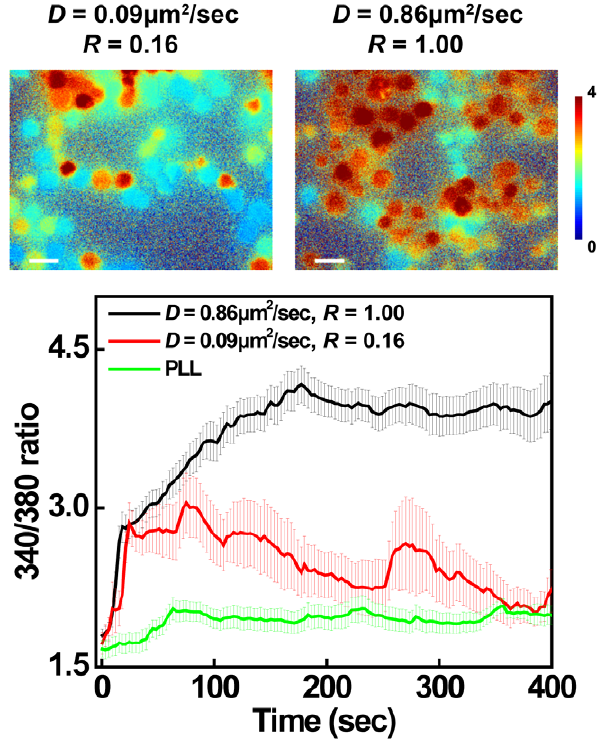
Figure 7. High ligand mobility triggers persistent intracellular calcium flux. Jurkat cells loaded with Fura-2 were plated on various bilayer surfaces, and intracellular calcium levels were monitored by widefield ratiometric imaging at 340/380 nm. Top, representative images of Fura-2 340/380 ratio after 20 minutes on different bilayer surfaces were depicted as a heat map (top). Scale bars=20 m m. Bottom, average Fura-2 ratios in cells activated on bilayers with highly mobile (black) or low mobility (red) bilayers were compared to those in control cells interacting with poly-L-lysine (PLL) -coated surfaces (green). Error bars represent the standard error of the mean.